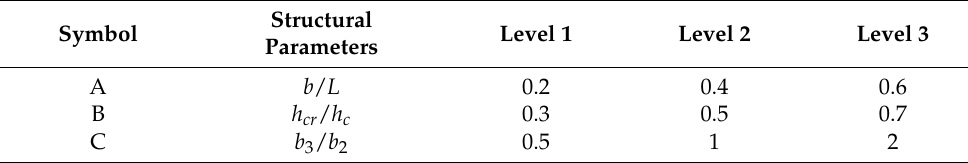
Table 3. Structural parameters and their